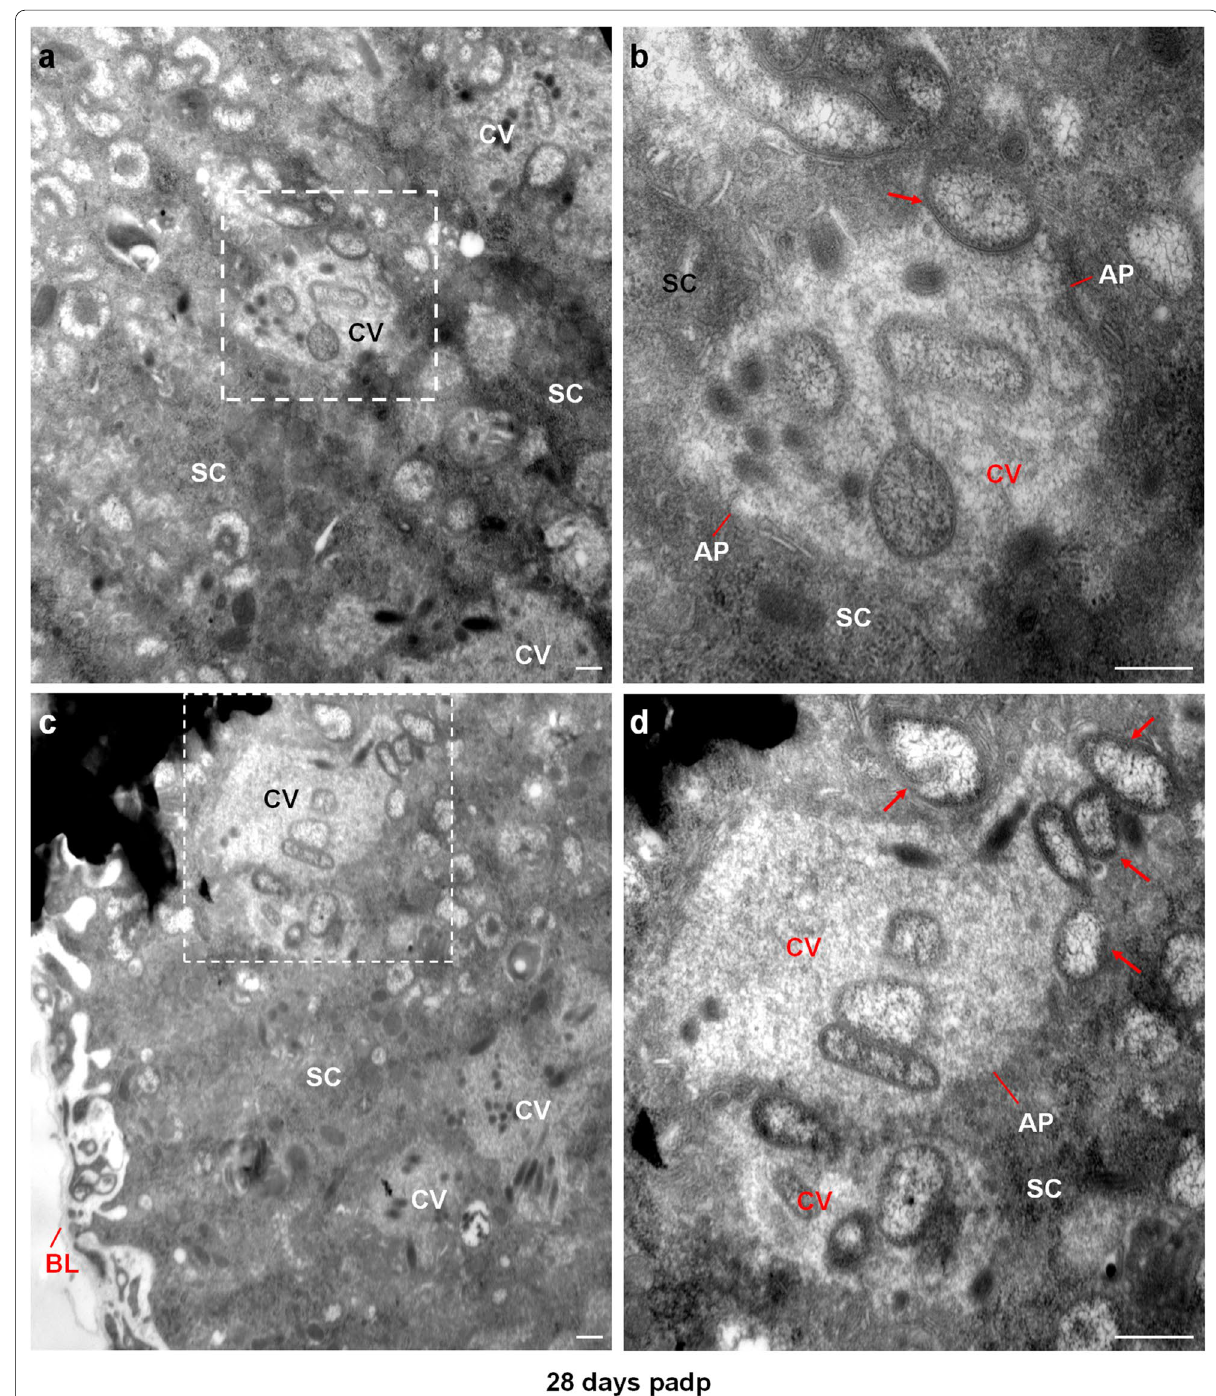
Fig. 5 Electron micrographs showing the release of ROLPs from the salivary cytoplasm into the cavities by crossing the apical plasmalemma of R. dorsalis . a – d Release of ROLPs into apical plasmalemma-lined cavities. b and d are the enlarged images of boxed areas in a and c , respectively. Arrows indicate the ROLPs which are directly squeezing or penetrating the apical plasmalemma into the cavities. AP, apical plasmalemma; BL, basal lamina; CV, cavity; SC, salivary cytoplasm. Scale bars, 200